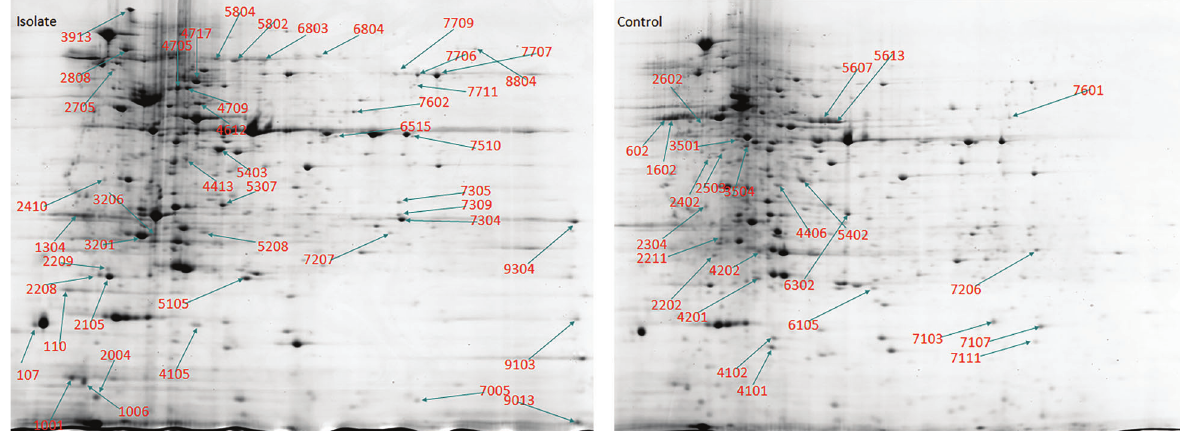
Figure 3. Comparative analysis of proteins of C. perfringens by 2D- electrophoresis. The image shows the differential expression of protein spots from the proteins extracted from ( left ) multidrug resistance isolate strain of C. perfringens , and ( right ) control strain. Proteins whose fold change were higher than 2 or less than 0.5 were selected for further analysis. The arrows refer to the differentially expressed protein spots.